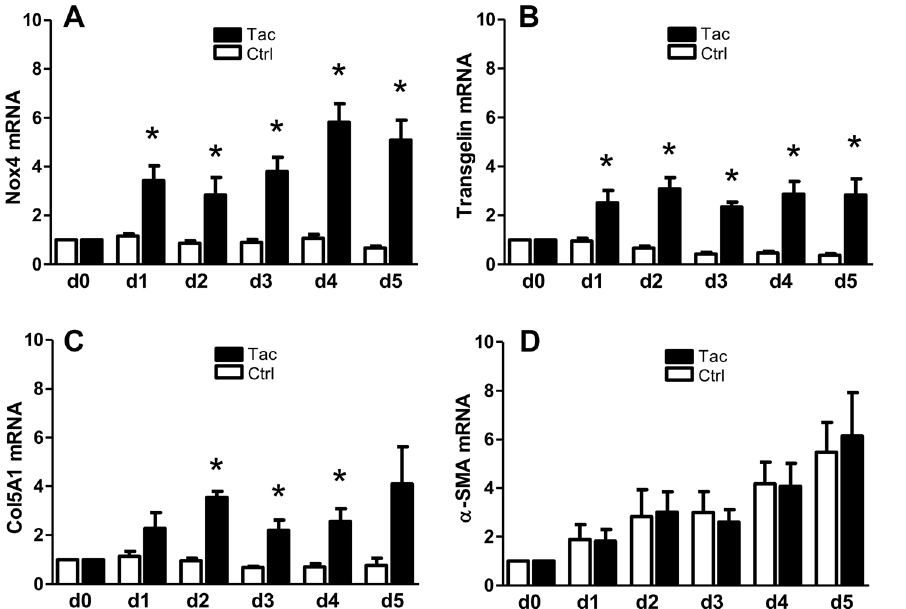
Figure 1. Time course of mRNA expression in TK-173 cells cells treated with 100 nM tacrolimus. Expression of mRNA for NAD(P)H- oxidase 4 (A), transgelin (B), procollagen a 1(V) (C), and alpha-smooth muscle actin (D) in untreated cells (open columns), and cells treated with 100 nM tacrolimus (filled). Cells were switched to serum-free medium on day -1, and were then exposed to 100 nM tacrolimus starting at day 0. Cell samples were collected from day 0 to day 5. All results were normalized to day 0. Cells showed a significant response to tacrolimus after one day (Nox4 and transgelin) or two days (tropomyosin-1), respectively. Alpha-smooth muscle actin mRNA showed a slow up-regulation in both treated and untreated cells, most likely as a reaction to serum deprivation. (*) denotes significant (p # 0,05) difference between tacrolimus-treated and control cells at the same timepoint.